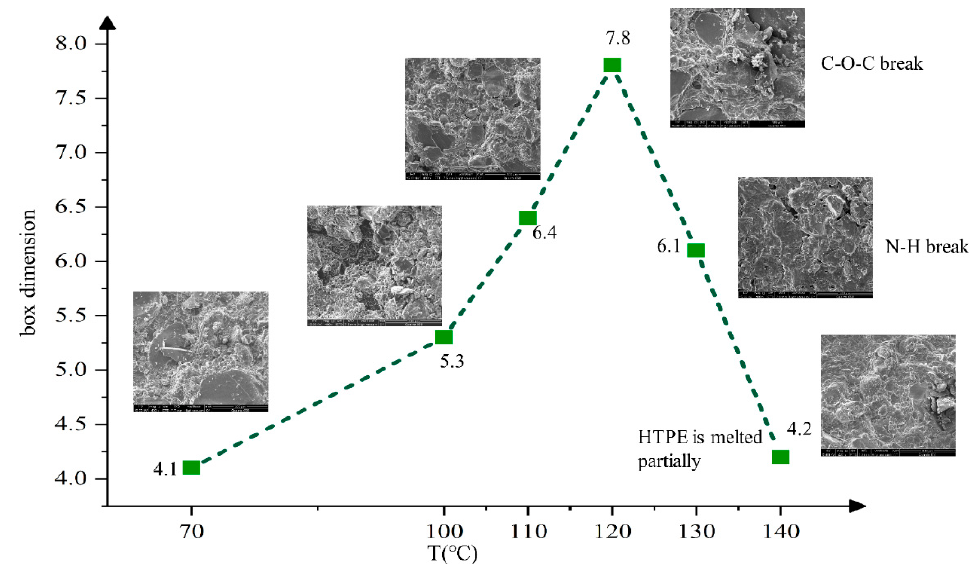
Figure 15. Defect figure of HTPE propellant at different temperatures during slow cook-off.